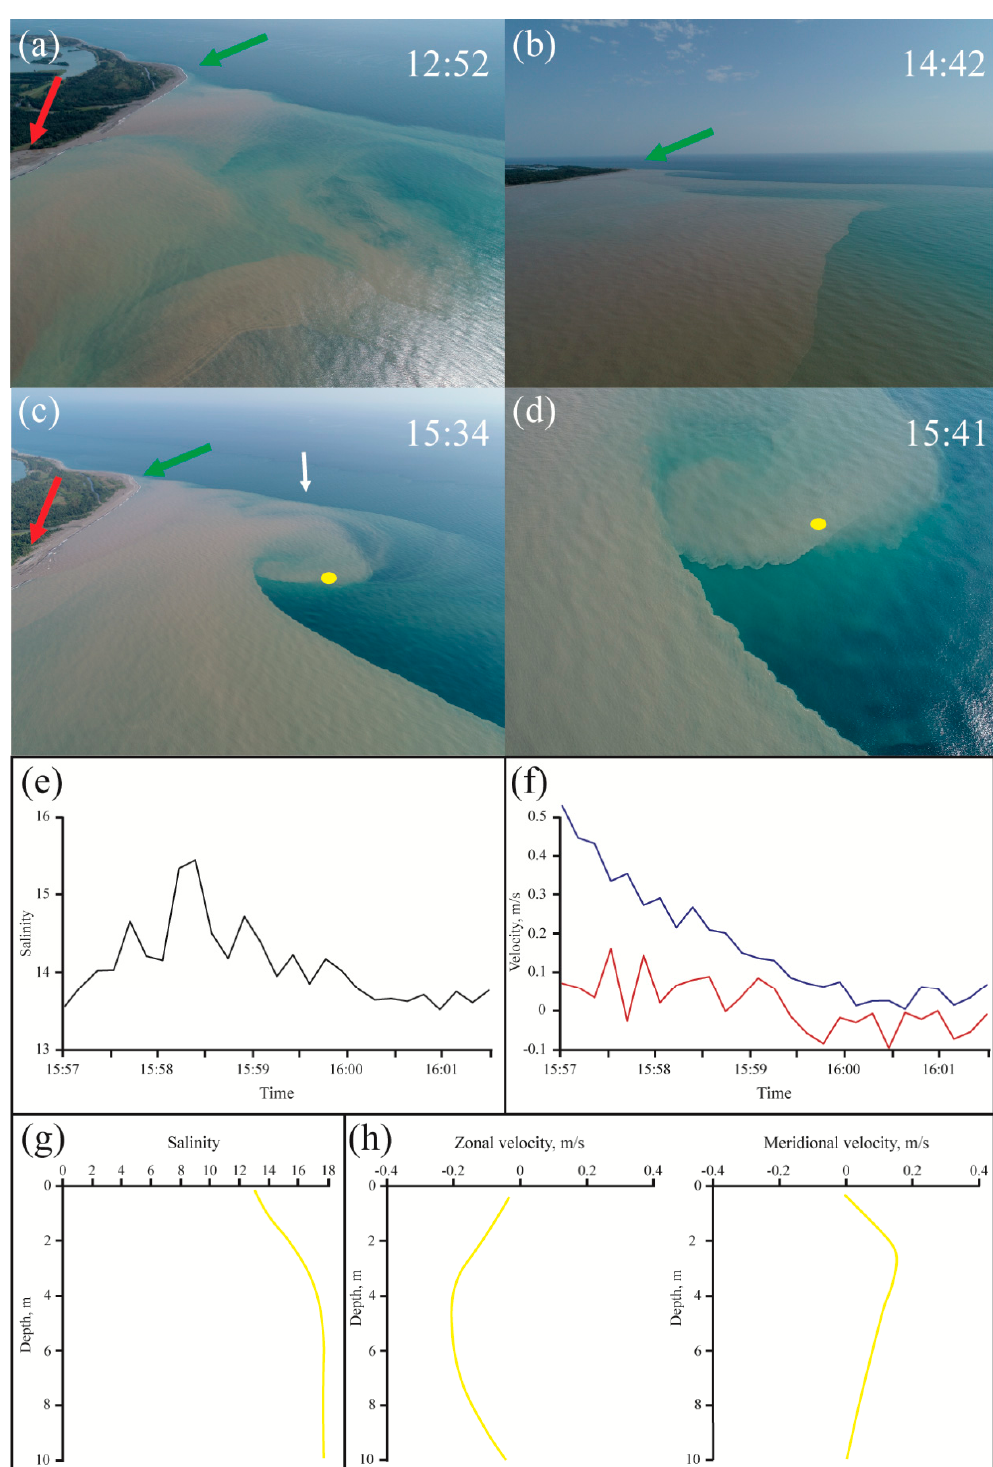
Figure 7. Aerial images of the southern part of the Kodor plume ( a,b ) before and ( c ) during interaction between the plume and the eddy acquired at ( a ) 12:52, ( b ) 14:42, ( c ) 15:34, and ( d ) 15:41 on 1 September, 2018. ( e ) surface salinity, ( f ) zonal (blue) and meridional (red) velocities measured during 15:57—16:01 and ( g ) vertical salinity and ( h ) velocity profiles measured at 16:02 within the eddy. Yellow dots in panels ( c ) and ( d ) indicate location of salinity and velocity measurements. The white arrow in panel ( c ) indicates location of the eddy, red arrows indicate location of the central deltaic branch of the Kodor River, and green arrows indicate location of the Iskuria Cape.